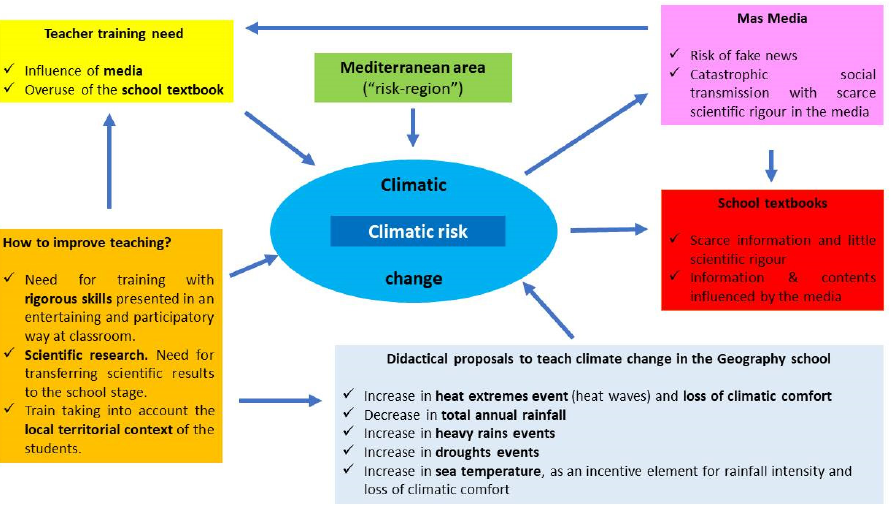
Figure 7. Fundamental aspects for teaching atmospheric risks in Secondary Education and Baccalaureate. Source: own elaboration.